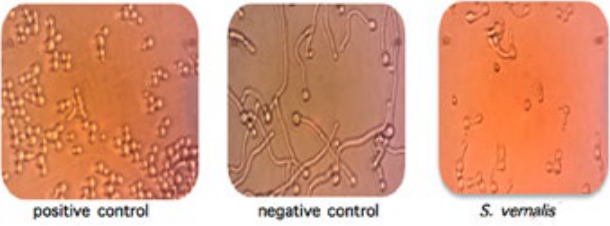
FIGURE 3 - Photomicrography (400x using phase contrast microscopy) of C.albicans ATCC 90028 blastospores after 3 h aerobic incubation at 37 °C.